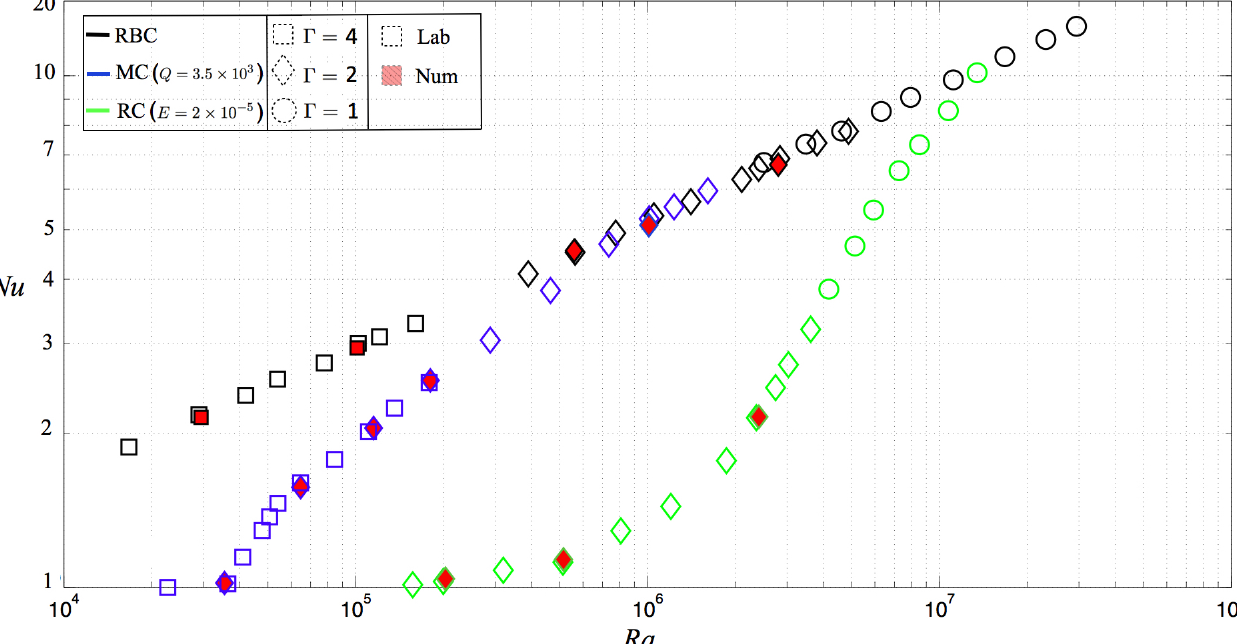
Figure 3. Compiled convective heat transfer measurements in liquid gallium. Heat transfer efficiency, parameterized by the Nusselt number, Nu , is plotted versus the buoyancy forcing, parameterized by the Rayleigh number, Ra . Square symbols denote